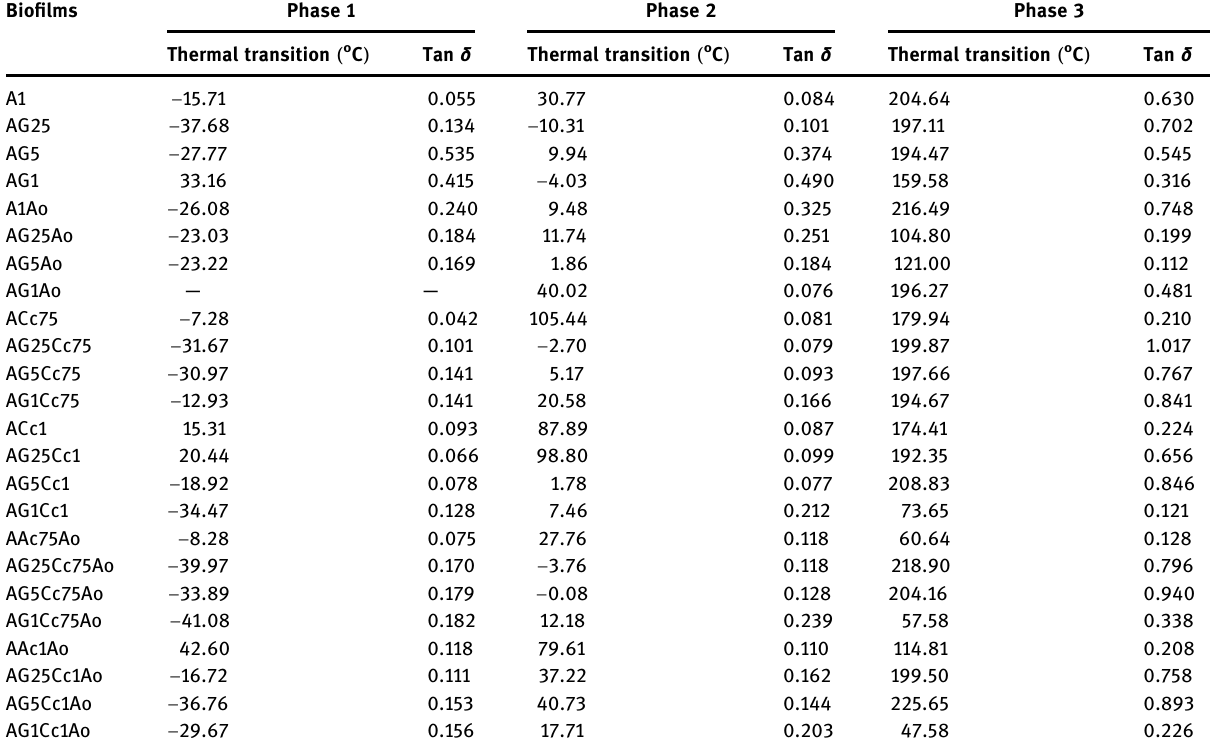
Table 3: Damping properties at the transition temperature of the alginate/glycerol/oleic acid/CaCl 2 bio fi lm formulation Bio fi lms Phase